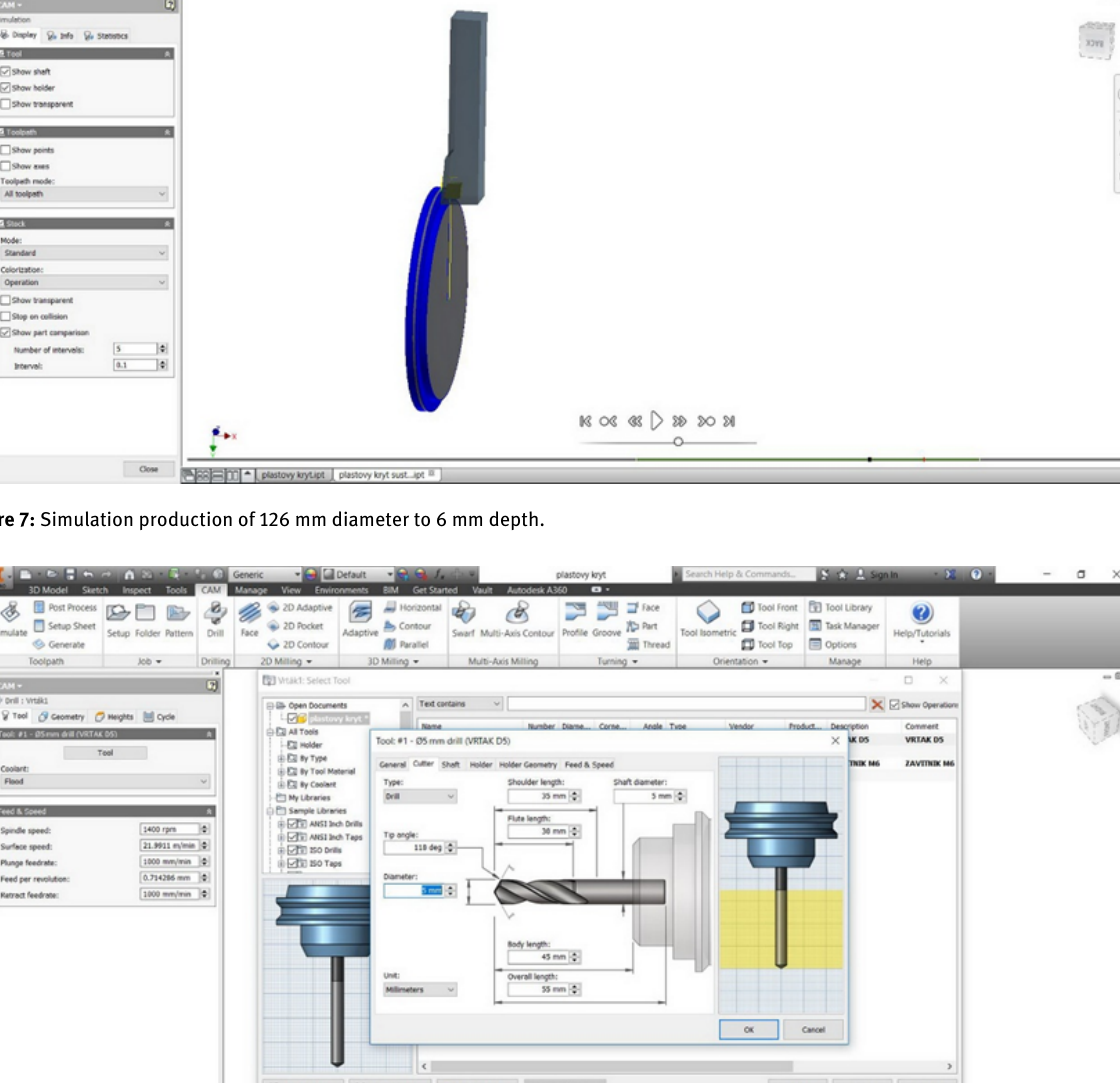
This is followed by drilling eight holes with a diameter D = 5mm. As in the previous operation, it is necessary to select a tool, define a feed rate of 250 mm·min-1 and a drill speed of 1200 RPM-1, see Figure 8.